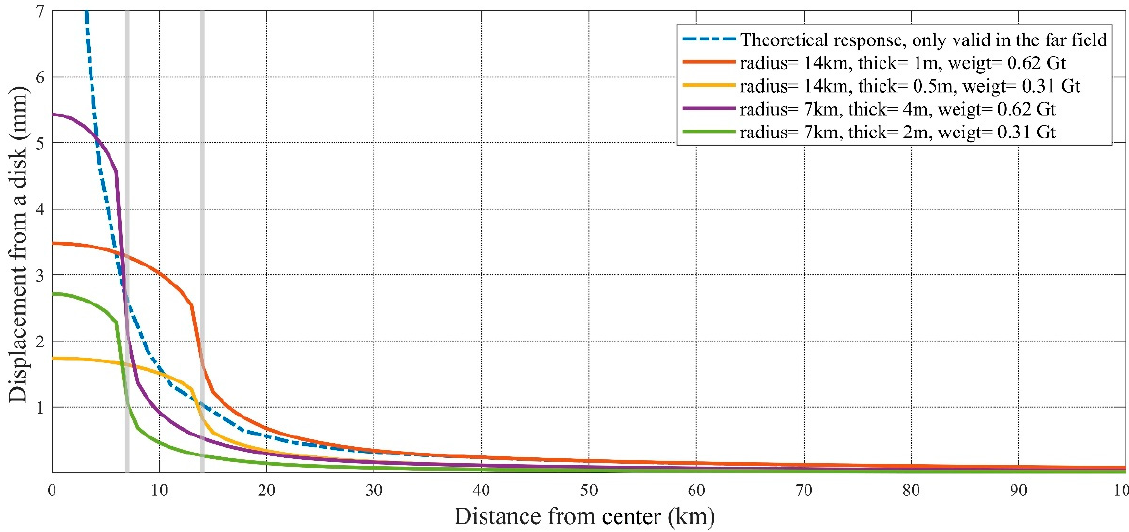
Figure 3. The relationship between the vertical deformation and center distance of disks with different mass and radius.